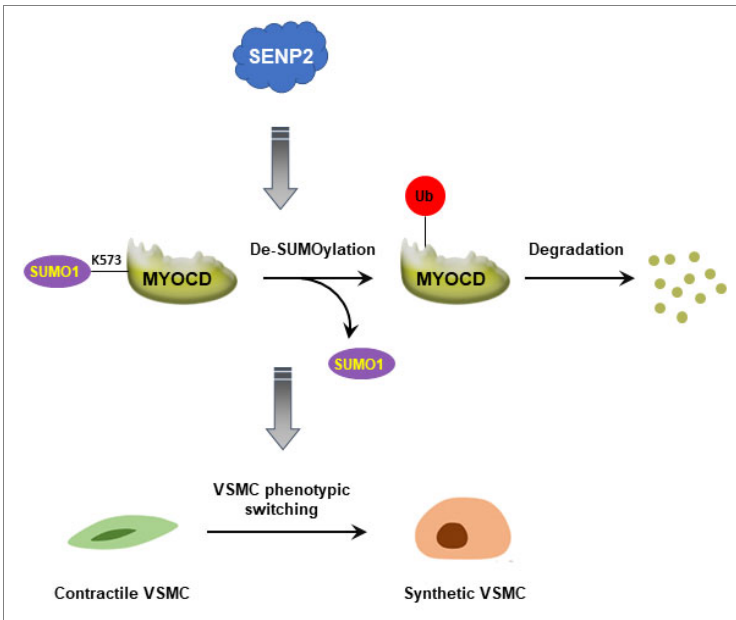
Figure 7. Schematic illustrating how SENP2 promotes VSMC phenotypic switching. In this study, we propose that SENP2 promotes VSMC phenotypic switching via de ‐ SUMOylation of myocardin and regulation of its protein stability.